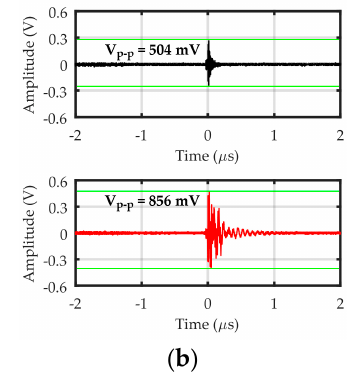
Figure 11. The comparison of the exemplary UHF pulses registered by the commercial UHF disk antenna and prototype meandered PIFA for ( a ) surface PD of an apparent charge of q = 625 pC, ( b ) creeping spark of apparent charge of q = 4670 pC.